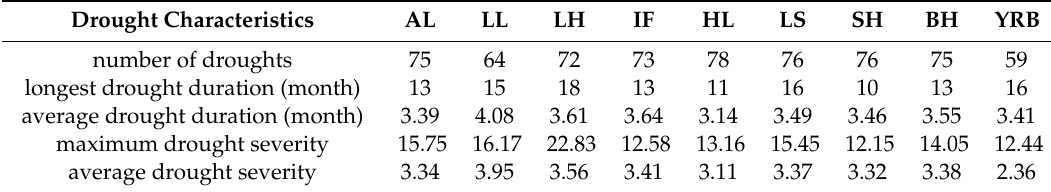
Table 5. Drought characteristics in the YRB during